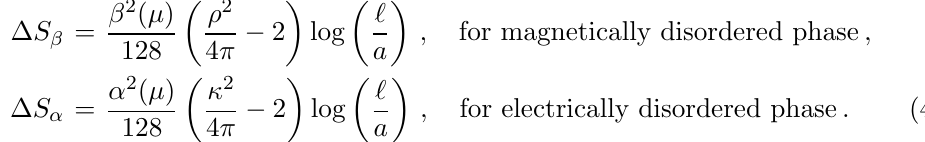
Figure 3 . The one-dimensional space in 1 + 1 CFT is tripartitioned into regions length of region